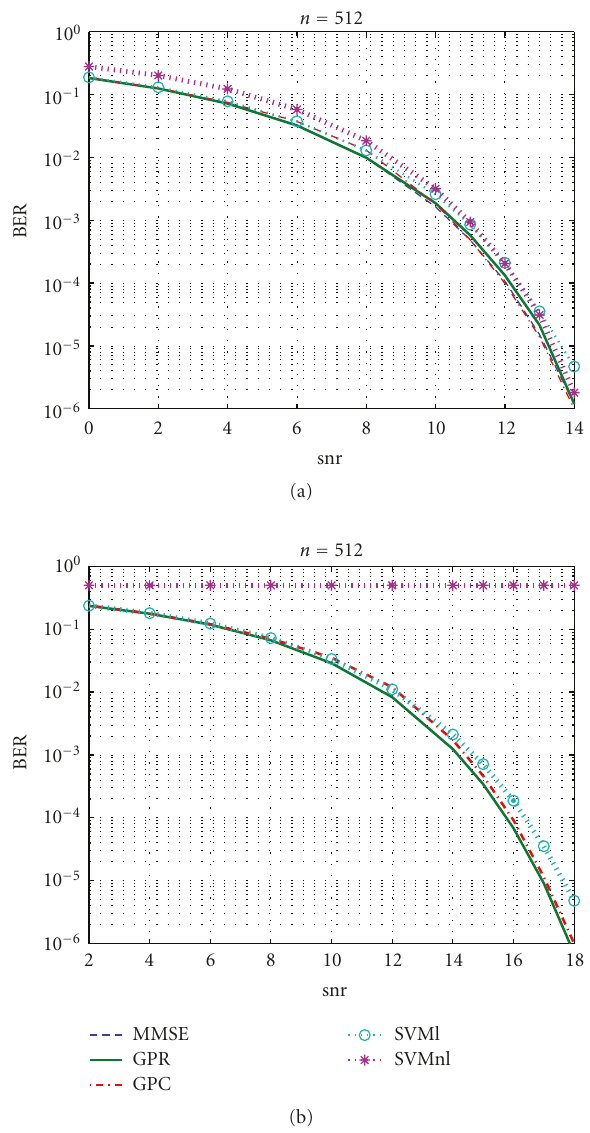
Figure 1: We report the BER versus the snr for a multiuser detector with 3 users in (a) and 16 users in (b). The dashed line represents the linear MMSE receiver, the solid line the GPR, the dash-dotted line the GPC, the dotted line with circles the linear SVM, and the dotted line with bullets the nonlinear